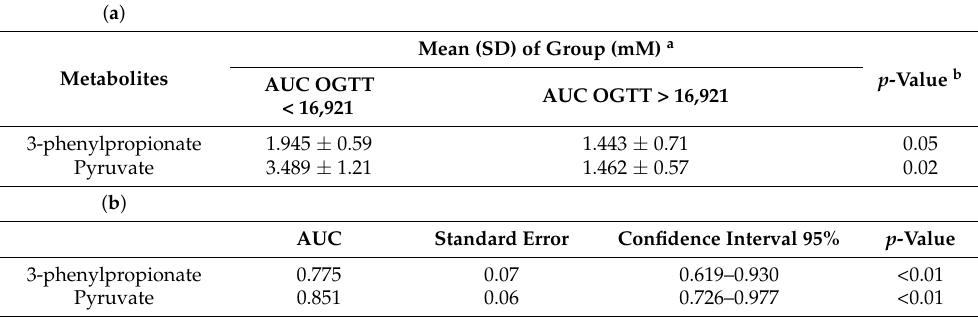
Table 3. Parameters OPLS model .